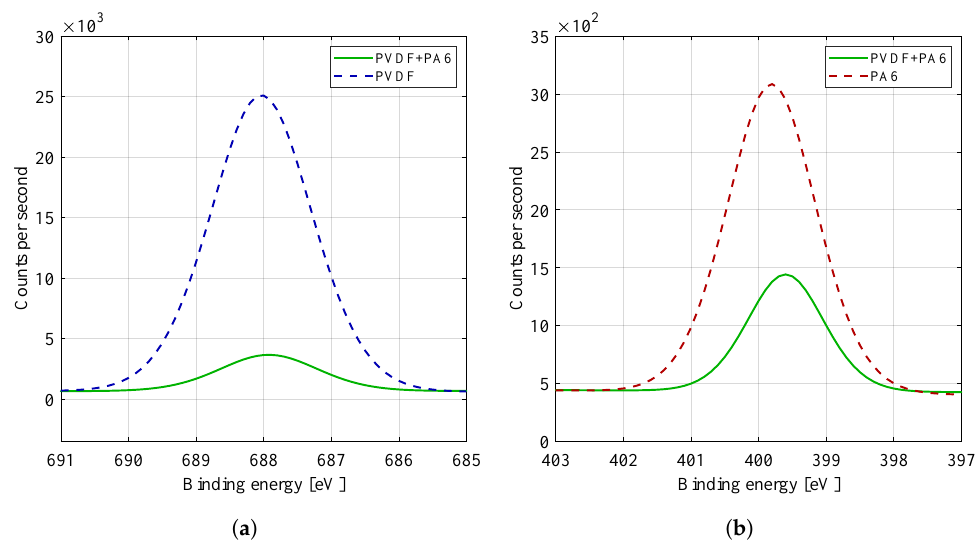
Figure 8. High energy resolution XPS spectra of ( a ) F1s and ( b ) N1s region. For practicality and a better overview, the curves of the given materials were plotted in one graph.